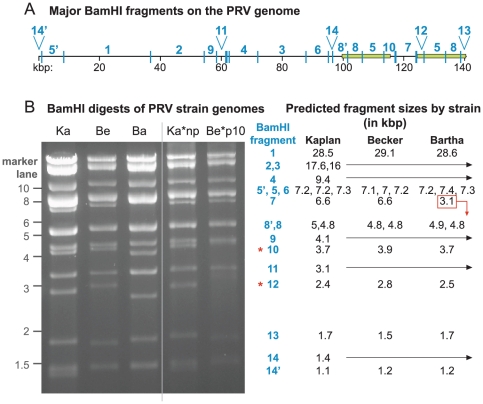
BamHI RFLP confirmation of PRV genome assemblies.A) Location of major BamHI fragments along the PRV Kaplan genome. Fragments are identified by historical fragment numbering [41]. Genome position in kilobase pairs (kb) is listed below the fragments, with the large inverted repeats IR and TR shown as green boxes. B) RFLP analysis of BamHI fragments of PRV strains Kaplan (Ka), Becker (Be), Bartha (Ba), an unpurified Kaplan stock (Ka*np), and a Becker stock passaged 10 times in vitro (Be*p10). Positions of a standard marker are noted on the left. Major BamHI fragments, and their predicted size in each strain, are indicated to the right at their approximate height in the gel image. The Bartha deletion causes a major size shift in BamHI fragment 7 (boxed; now 3.1 kb); the new band co-migrates with BamHI fragment 11 (also 3.1 kb). All bands except the variable fragments 10 and 12 (red asterisks) match their predicted sizes. Arrows from Kaplan through Becker and Bartha columns indicate bands that are predicted to be of equivalent size in all three strains.